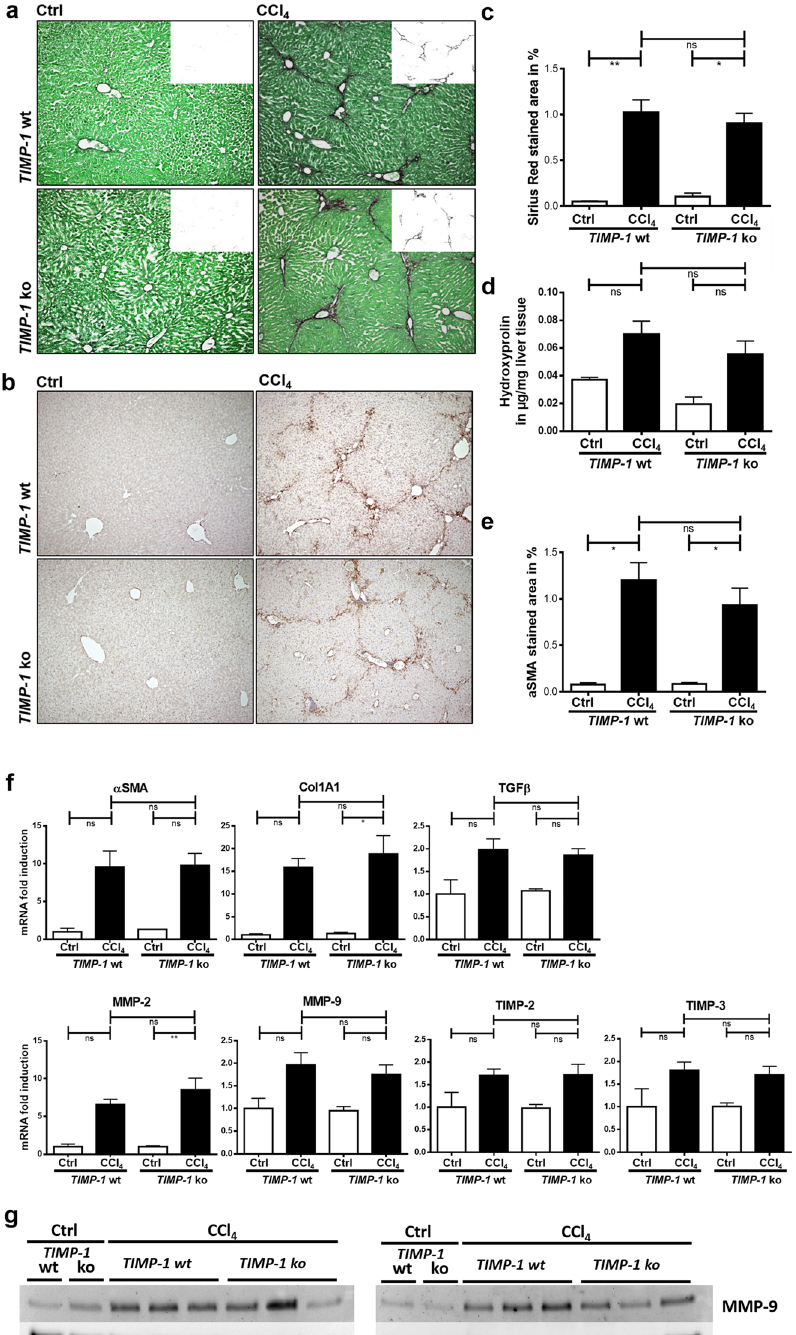
Figure 3. TIMP-1 deficiency does not prevent hepatic fibrogenesis following CCl 4 treatment. ( a ) Collagen content of livers following chronic CCl 4 treatment was assessed by Sirius Red staining. TIMP-1 deficiency does not alter collagen content compared to TIMP-1 wt, as shown in representative images and ( c ) in quantification of Sirius Red positive stained area. ( d ) Supportively hepatic hydroxyproline content also did not differ between TIMP-1 deficient and wildtype animals following CCl 4 treatment ( b , e ) α SMA IHC indicates hepatic stellate cell activation and was increased in livers following CCl 4 administration. TIMP-1 ko have the same amount of α SMA positive cells compared to TIMP-1 wt. ( f ) Fibrosis-related genes were upregulated in livers after CCl treatment, but no differences could be observed between TIMP-1 wt and TIMP-1 ko mice. Not only MMP-9 gene expression was not altered, but ( g ) also Western blot analysis of MMP-9 protein showed no differences in TIMP-1 ko livers compared to wildtypes. Displayed are cropped images. Full-length blots are presented in Supplementary Figure 3. Bar columns represent mean ± standard error of the mean. ** p < 0.01; * p < 0.05; ns (non-significant). (Untreated controls n = 3–5, CCl 4 n =